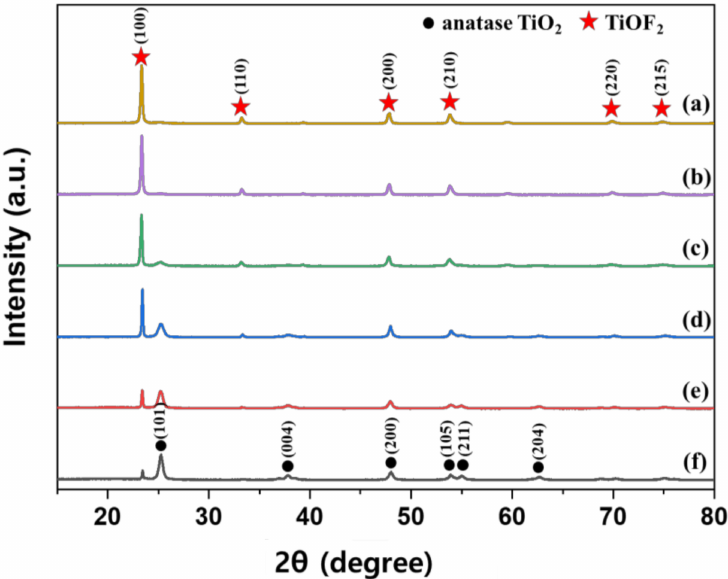
Figure 1. XRD patterns of the prepared TiOF 2 at various reaction temperatures; ( a ) 300 ◦ C, ( b ) 350 ◦ C,